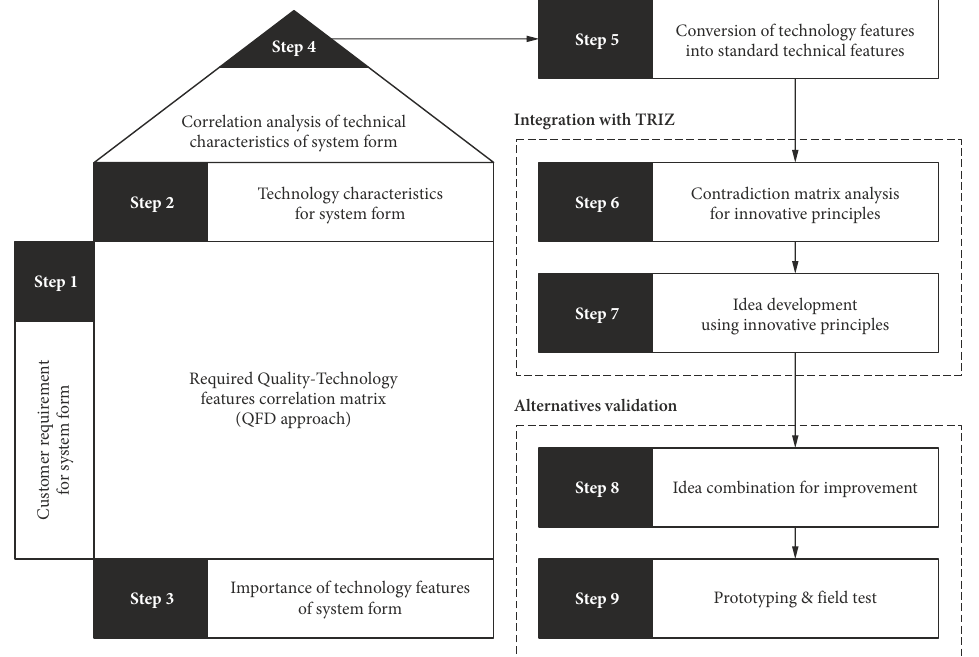
Figure 4. Design process for the concrete system form using QFD and